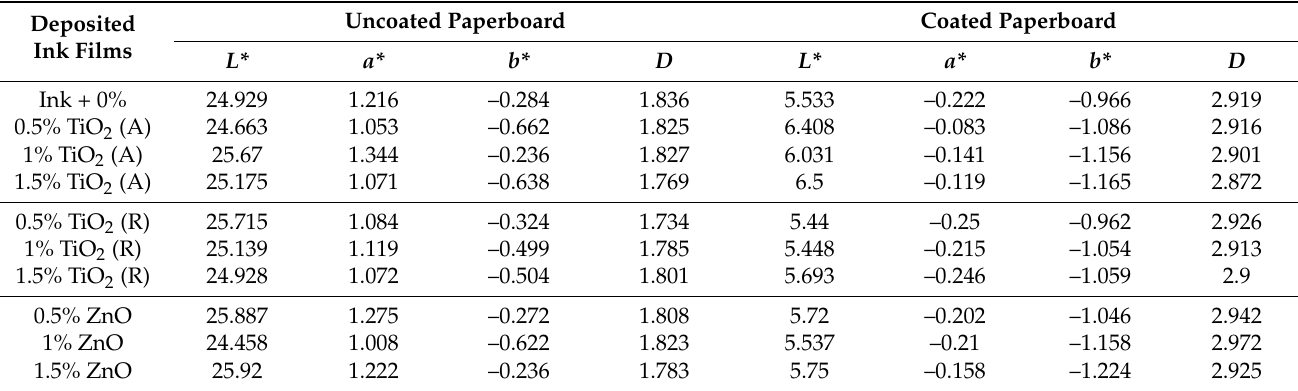
Table 6. Results of the CIE L*a*b* values and color density.